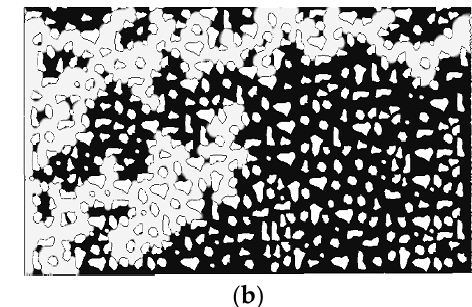
( b ) Figure 6. Flow distribution within the micromodel at rupture time. Injection velocity: 10 ft/day and IFT 0.03 mN/m. ( a ) Experimental and ( b ) simulation.